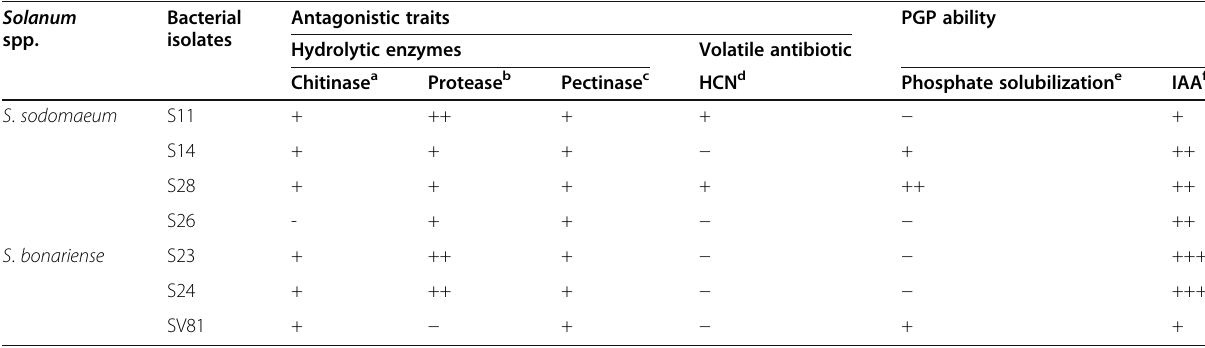
Table 2 Antagonistic and plant growth-promoting (PGP) mechanisms of the seven selected endophytic bacterial isolates recovered from Solanum sodomaeum and Solanum bonariense Solanum